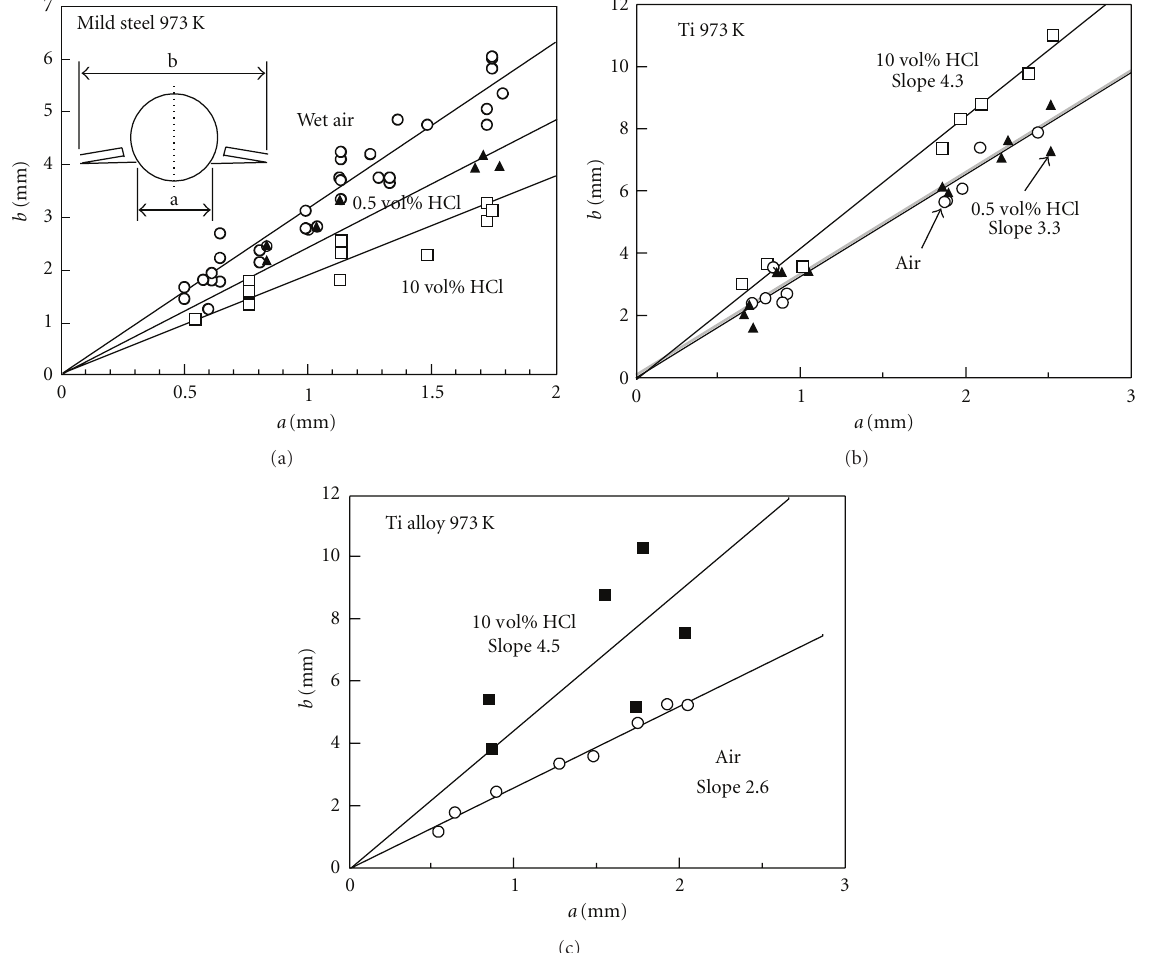
Figure 7: Relations between the diameters of indentation and of detached area in various high temperature corrosive